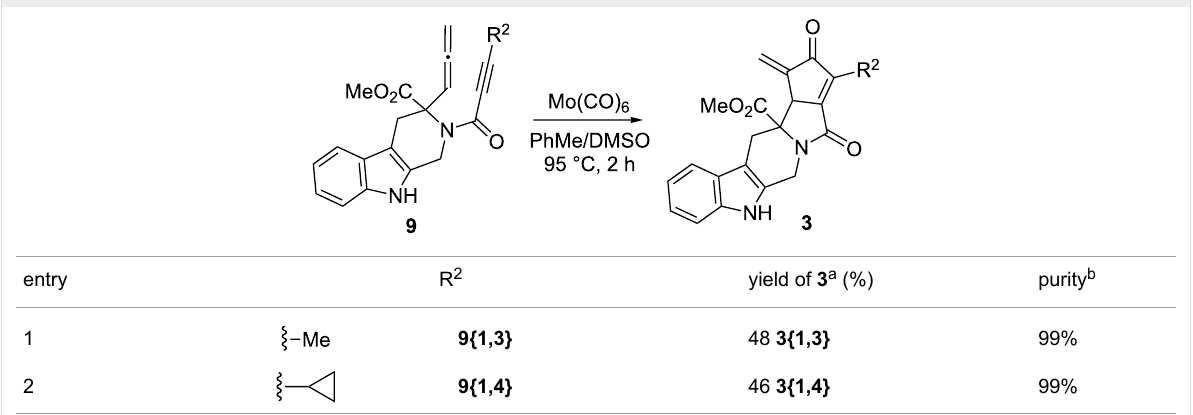
Table 3: Synthesis of α -methylenecyclopentenone library 3{1,3} – 3{1,4}